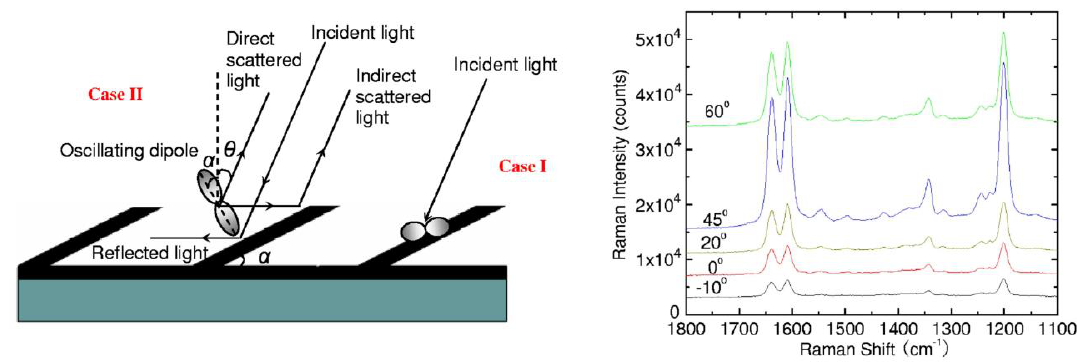
Figure 16. Left: Schematic illustration of the modified Greenler’s model of an induced dipole on a Ag nanorod: Case I, where the dipole is perpendicular to the incident plane; Case II, where the dipole is on the incident plane. All the induced dipoles are perpendicular to the NR. Right : Representative SERS spectra of trans-1,2-bis(4-pyridyl)-ethene adsorbed on the Ag NR substrate at different incident angles θ . The peak intensity was strongest at the angle θ around 45°, which was in agreement with the model. Adapted with permission from [96].